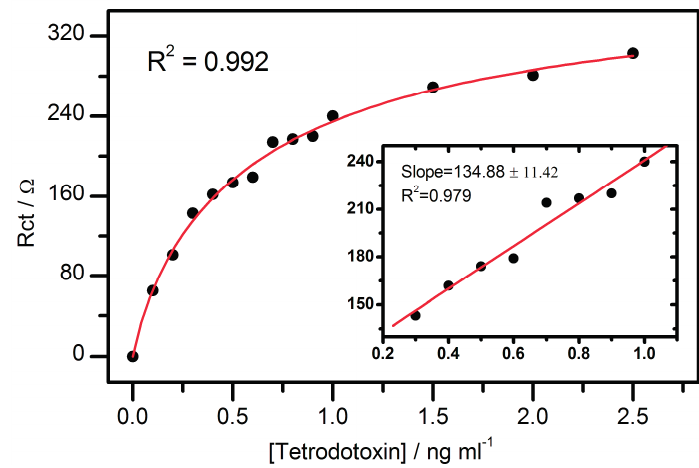
Figure 6. Calibration plot of the impedimetric TTX aptasensor (main graph); and the plot of the analytical linear range of the aptasensor (inset).